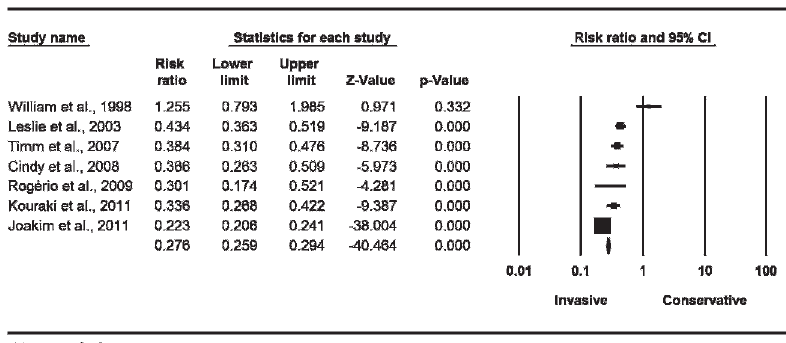
Figure 3 - Primary analysis of the NSTE-ACS OCS within 1